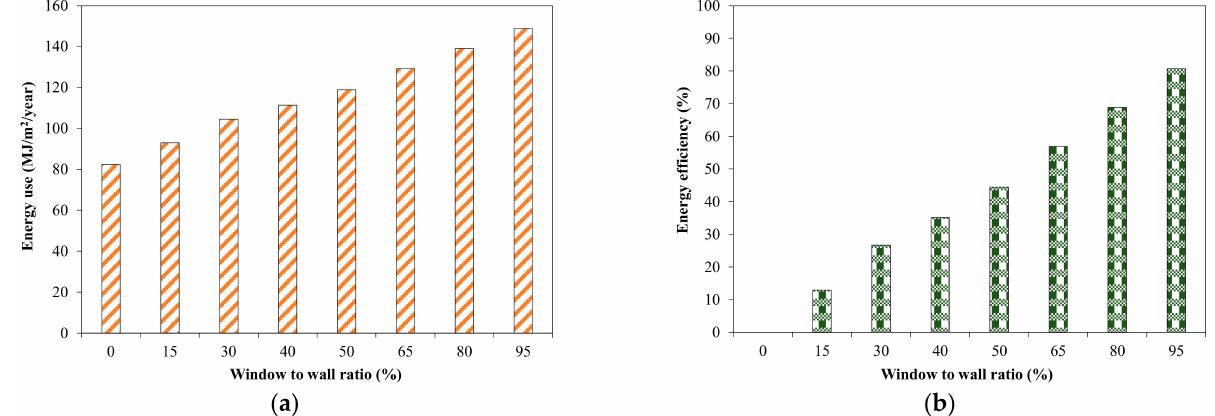
Figure 17. Effect of W/W ratio in energy use in tested house. ( a ) Energy use; ( b )